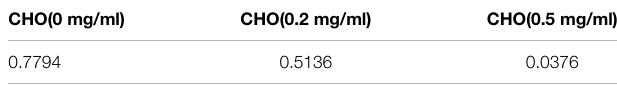
TABLE 3 | Cell adhesion experiments.